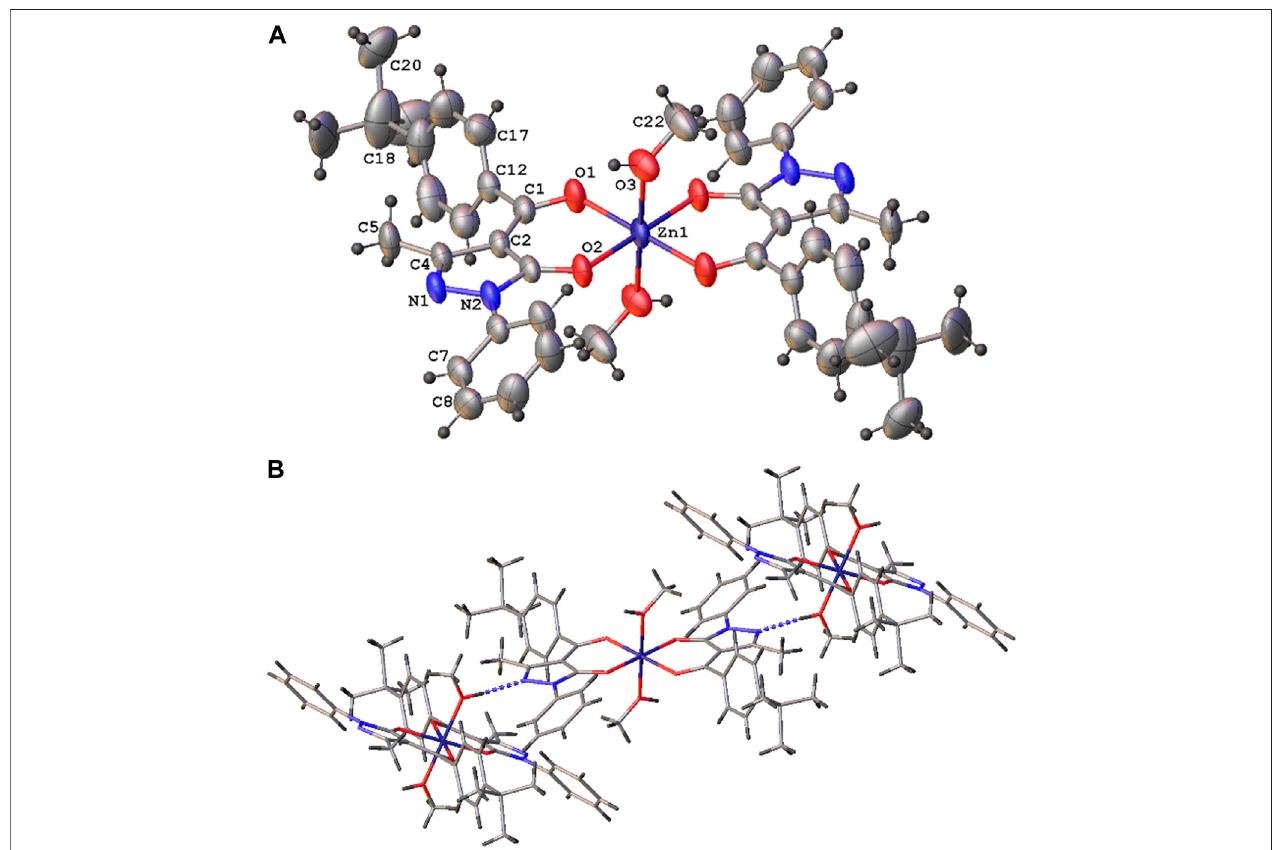
FIGURE 1 | Molecular structure of the [Zn(Q PhtBu ) 2 (MeOH) 2 ] complex (A) with atomic numbering scheme and (B) crystal packing view showing the predominant O – H – N interactions [O (3) – N (1) i 2.798 (2) Å, O (3)-H (3a)...N (1) 164 ° , i = x , - y +1/2, z